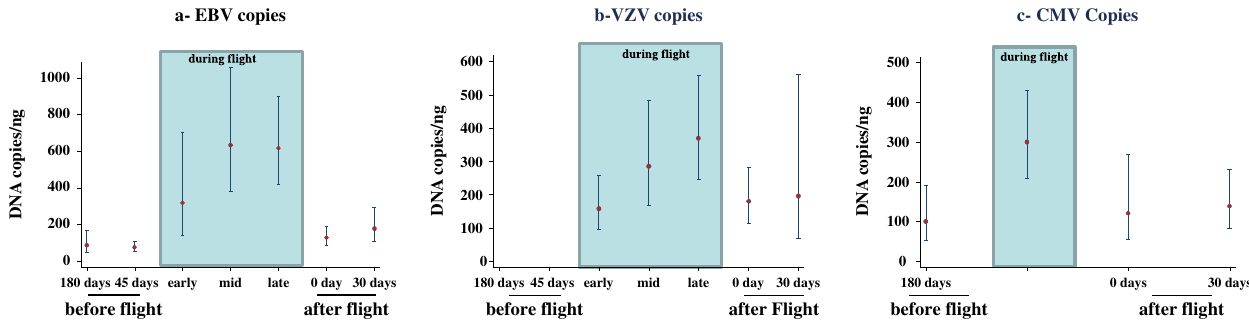
Fig. 2 Estimated median viral copies given that shedding has occurred, with 95% con fi dence intervals (mixed-model regression). a : EBV, b : VZV, c : CMV